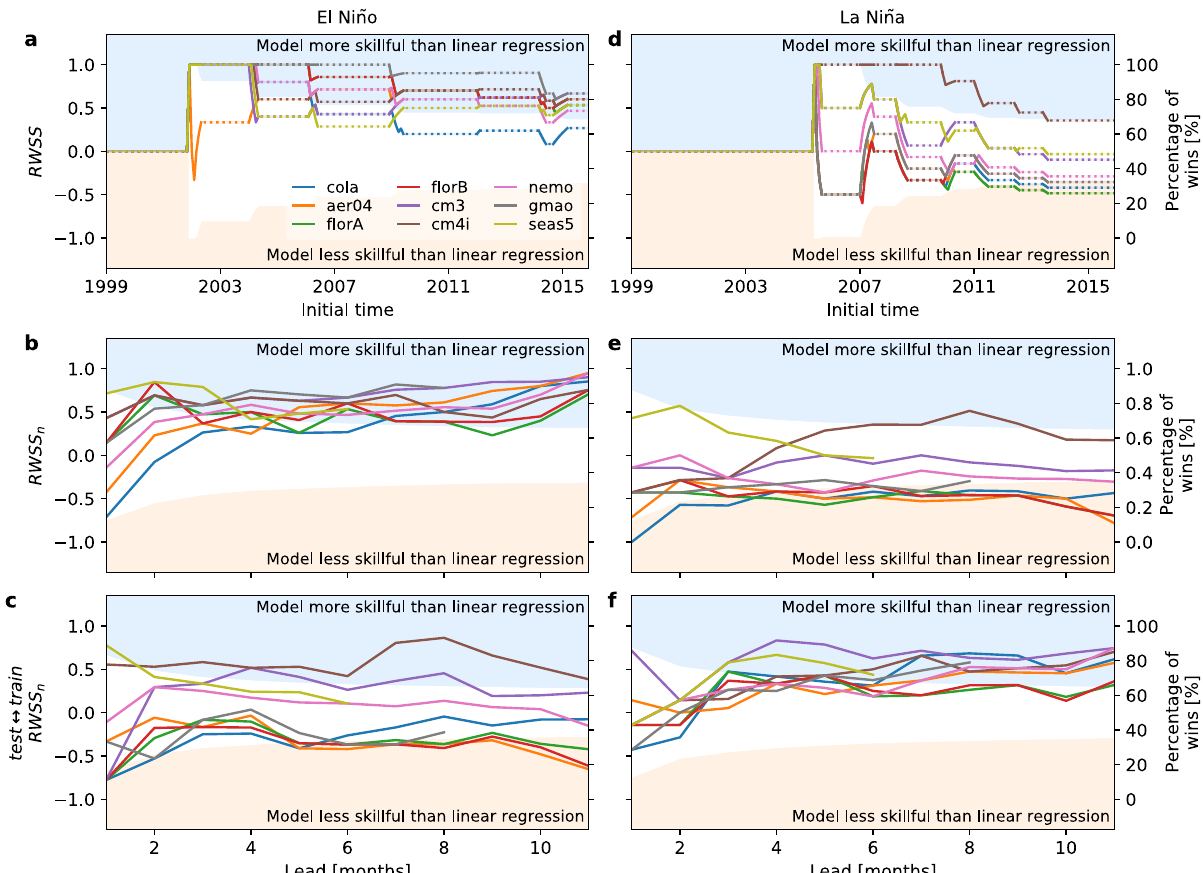
Fig. 5 Skill scores for El Niño and La Niña onset using the fair method. Random walk skill score ( RWSS ) at 6 months lead relative to linear regression for El Niño and La Niña onset ( a and d ). The dashed lines in the panel represent forecast comparison periods that do not correspond to `onset' comparisons. The fi nal random walk skill score, RWSS n , is shown as a function of lead time for El Niño and La Niña onset in panels b and e . Panels c and f are the same as panels b and e , except that the training and testing periods have been